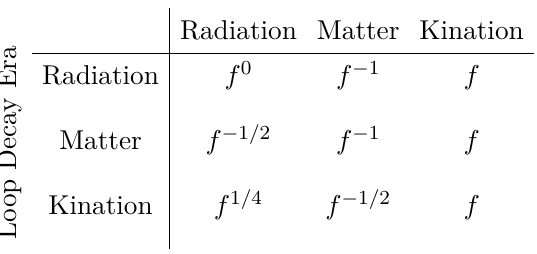
Table 1 . Frequency dependence of the m = 1 mode amplitude, Ω (1) ( f ) , for loops that form and decay in a radiation, matter, or kination-dominated